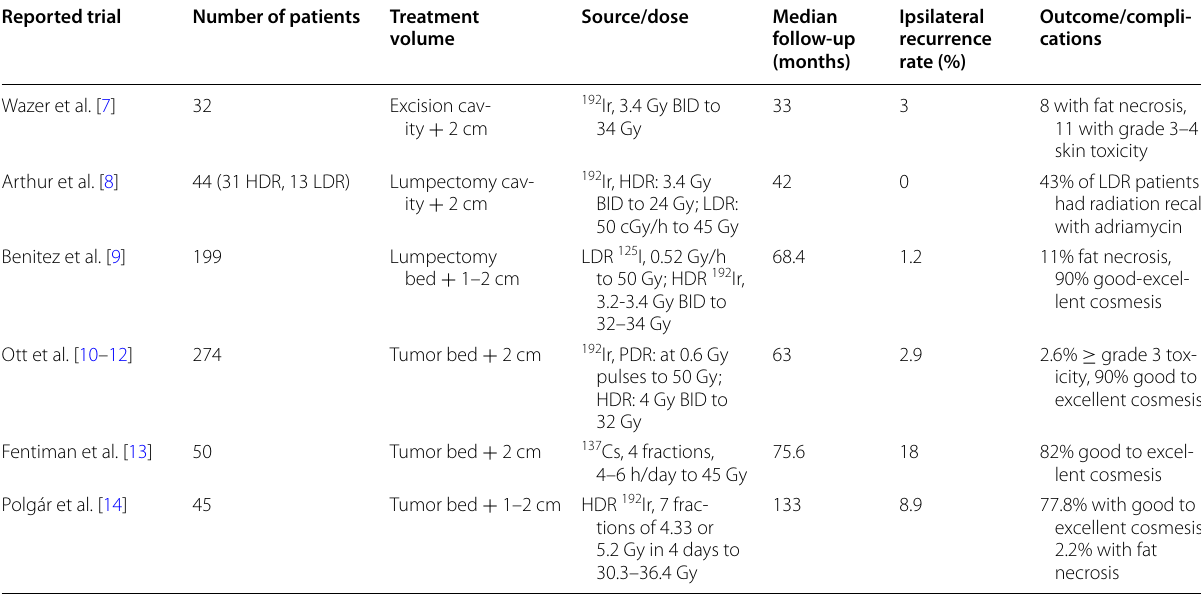
BID twice daily, HDR high-dose-rate, LDR low-dose-rate, PDR